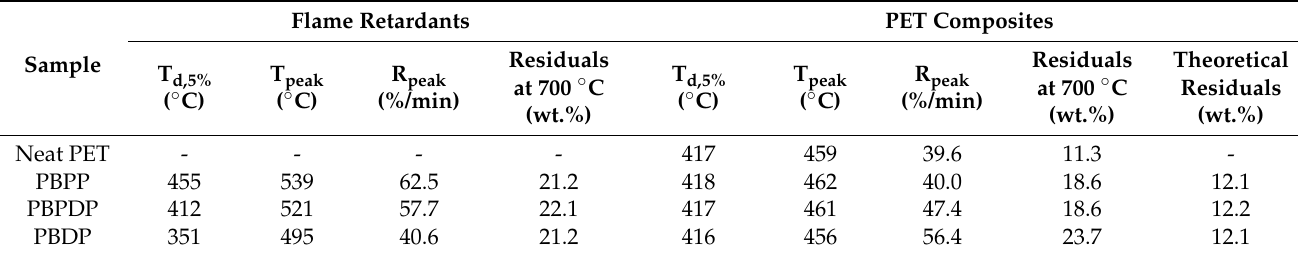
Table 1. The thermal parameters of flame retardants and PETs.